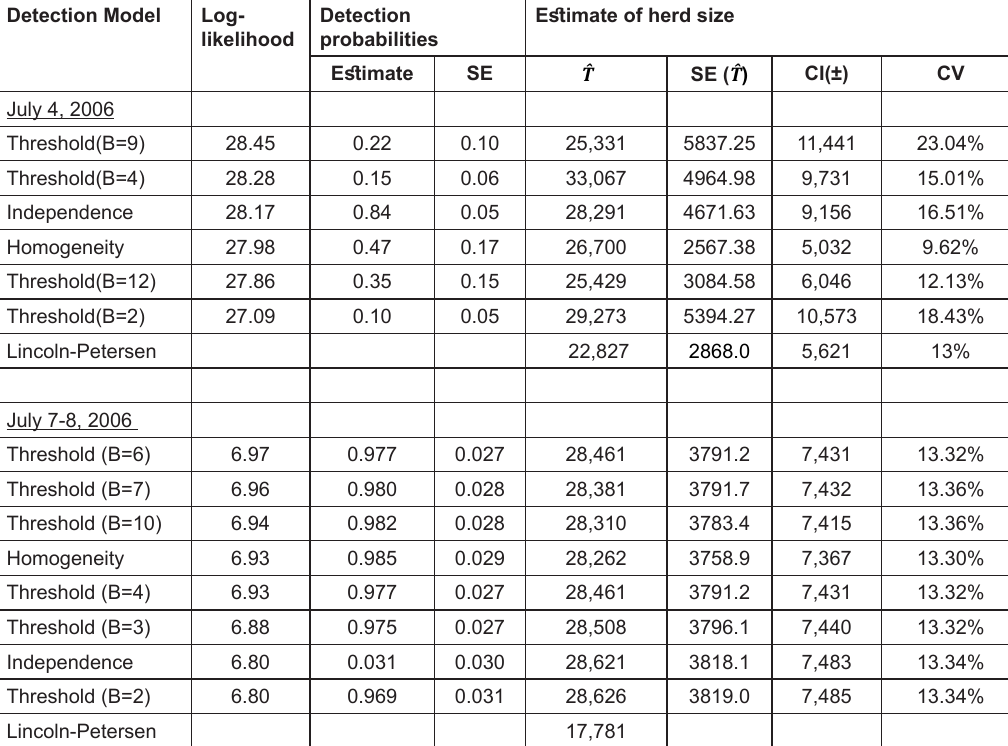
Table 11. Rivest Estimator results for the Bluenose-West July 4 and July 7-8, 2006 data sets (Nagy & Johnson. 2006). The Lincoln-Petersen estimate is based on Nagy & Johnson